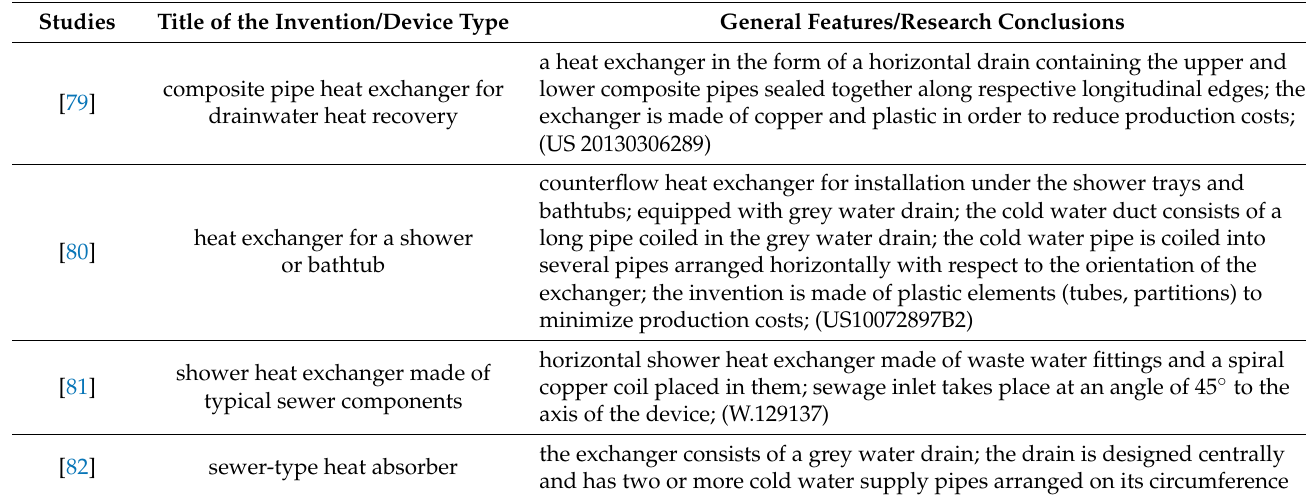
Table 1. Summary of the analyzed references regarding horizontal exchangers.